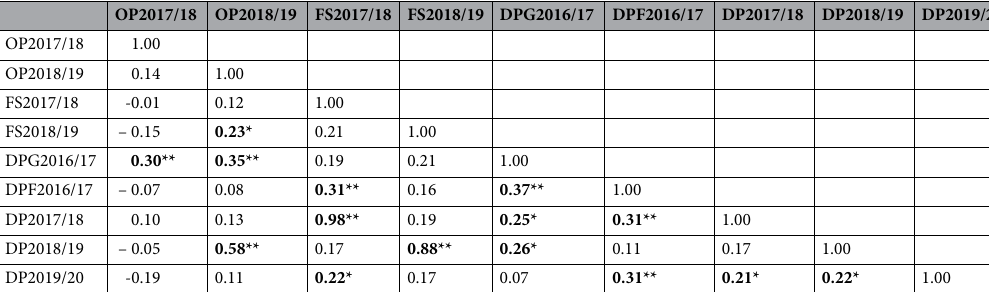
in 2016/17 showed no statistical differences between the parental lines. DP and FS showed a wider range of vari- ation than OP. The range of OP in the different seasons varied from 0 to > 65% (Table 1). Correlations among traits were evaluated across the four years at P < 0.05 and P < 0.01. As summarized in Table 2, the highest correlations were found between DP and FS in 2017/18 (0.98) and 2018/19 (0.88), followed by DP and OP in 2018/19 (0.58). Except for DP2019/20, DP values in the greenhouse showed moderate but significant correlations ranging from 0.25 to 0.37 with the rest of the DP field ratings. There were also significant correlations between 0.21 and 0.31 among the DP field values except between DP2018/19 with DPF2016/17 and DP2017/18. No correlation was detected among the OP field values in 2017/18 and the DP data collected in the other three years, except for DPG2016/17. A strong attack of aphids during the flowering and podding period in 2018/19 and the high incidence of broomrape ( Orobanche crenata ) in 2017/18 might be the main reasons for the lack of correlation between the traits recorded (Table 2). ANOVA results for the genotype x environment (G x E) analyses of each evaluated trait are shown in Sup- plementary Table 1. For all traits, significant differences were obtained between Genotype (RILs) and Environ- ment (years of evaluation). For OP and DP evaluations, significant differences were also obtained for the G x E interaction, suggesting that pod opening differed for a certain genotype across the years.